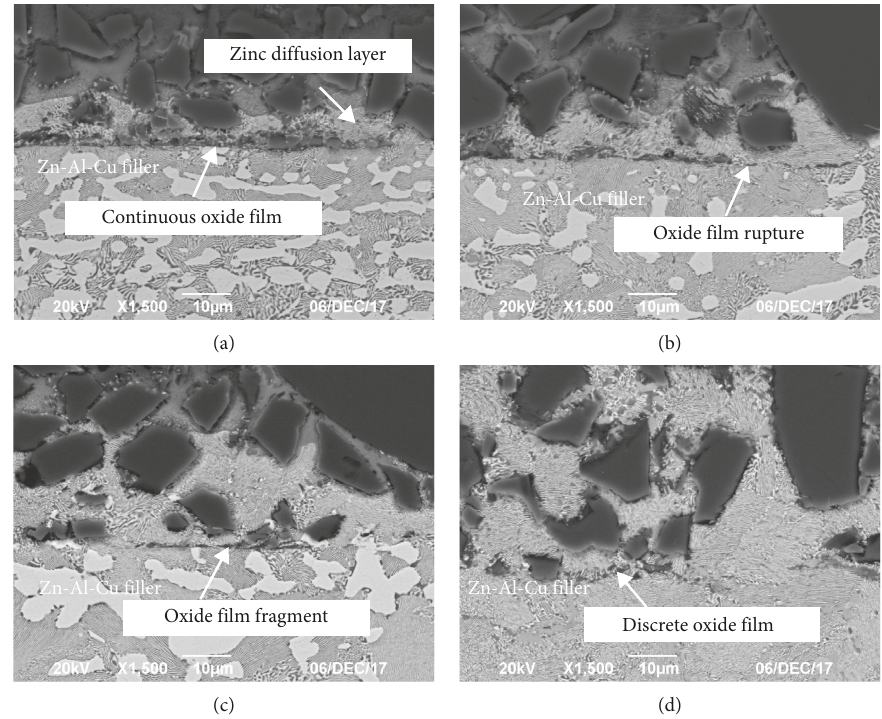
Figure 3: The interfacial structure of the joint brazed at different temperatures: (a) 382 ° C; (b) 386 ° C; (c) 392 ° C; (d) 410 °